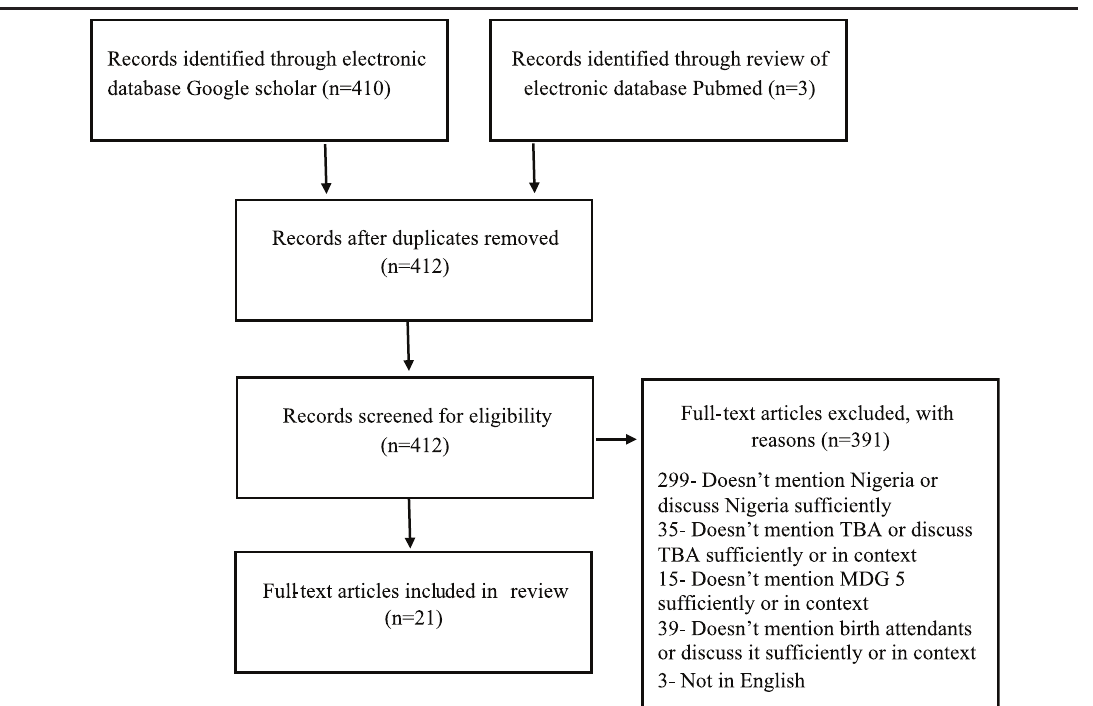
Figure 1: Illustrates the PRISMA model for the literature review conducted on TBA and MDG